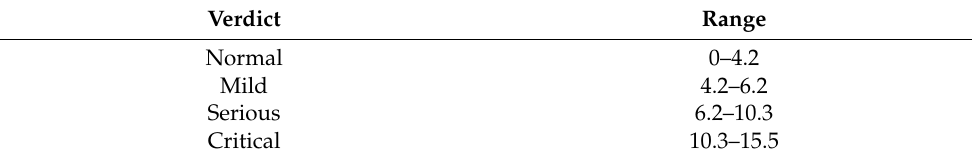
Table 6. The weight range for the verdict